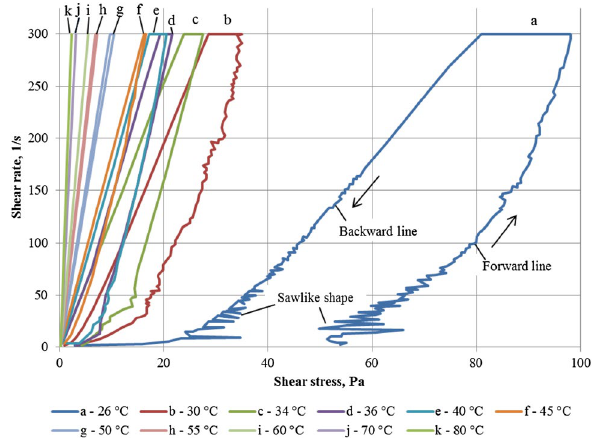
Fig. 7 Effect of shear rate on shear stress at different